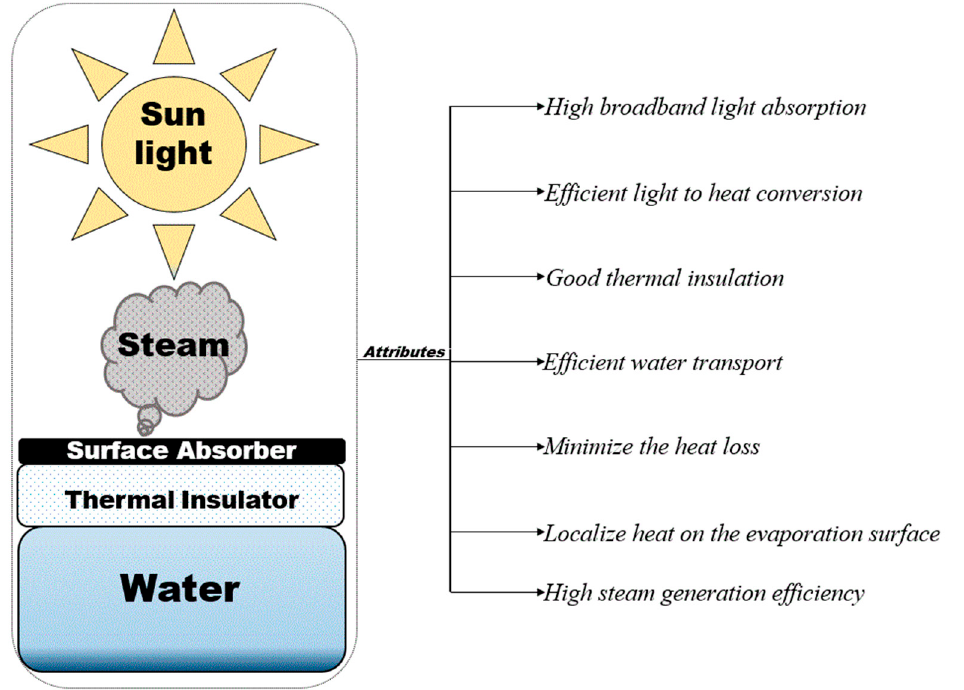
Figure 1. Schematic displaying the features of the solar-driven interfacial evaporation (SDIE) sys-